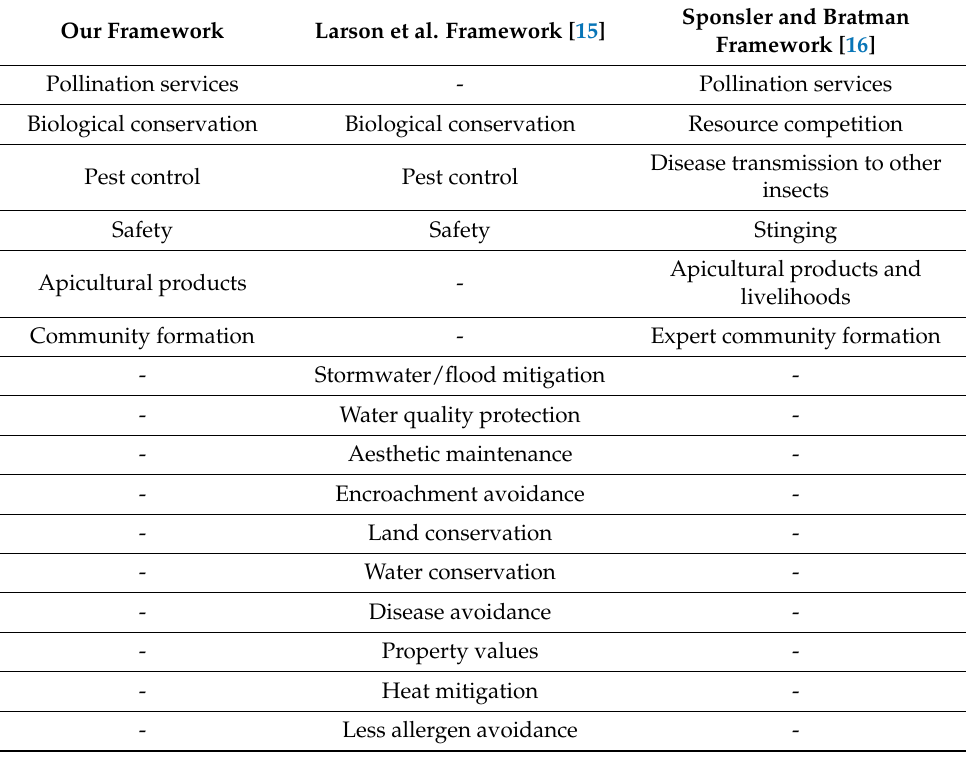
Sponsler and Bratman Framework [16]